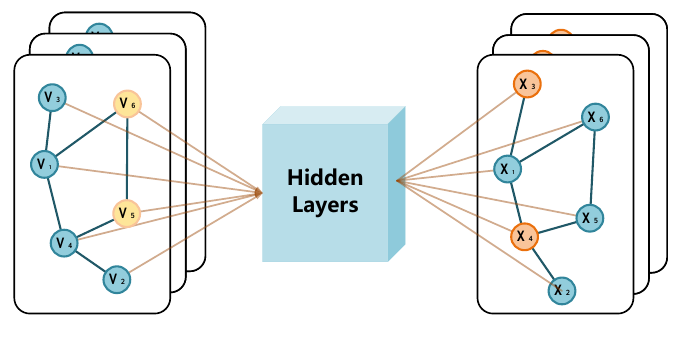
Figure 6. Basis structure of